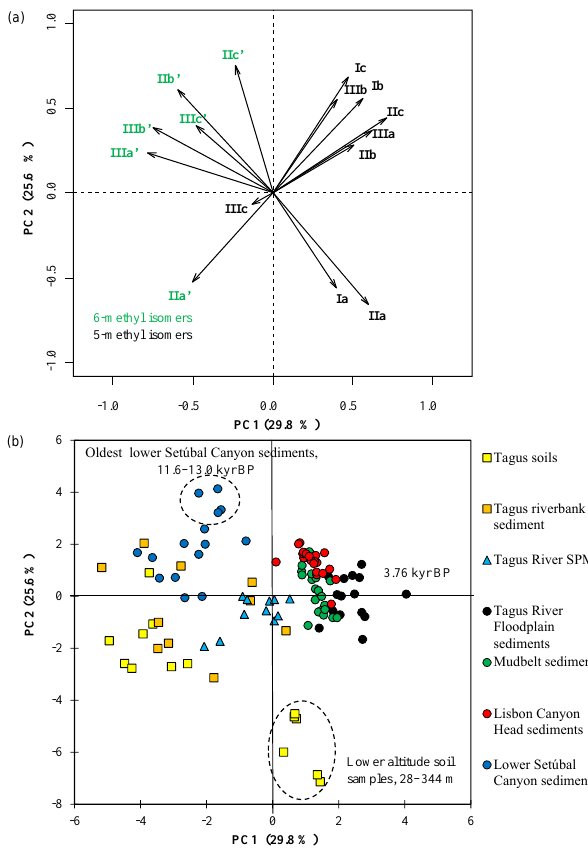
Figure 6. Principal component analysis based on the fractional abundances of the 15 brGDGTs of samples in the transect that runs from inland to off the coast of Portugal plotting (a) the scores of the brGDGT compounds on the first two principal components and (b) the scores of the samples from each sample set used in this study.